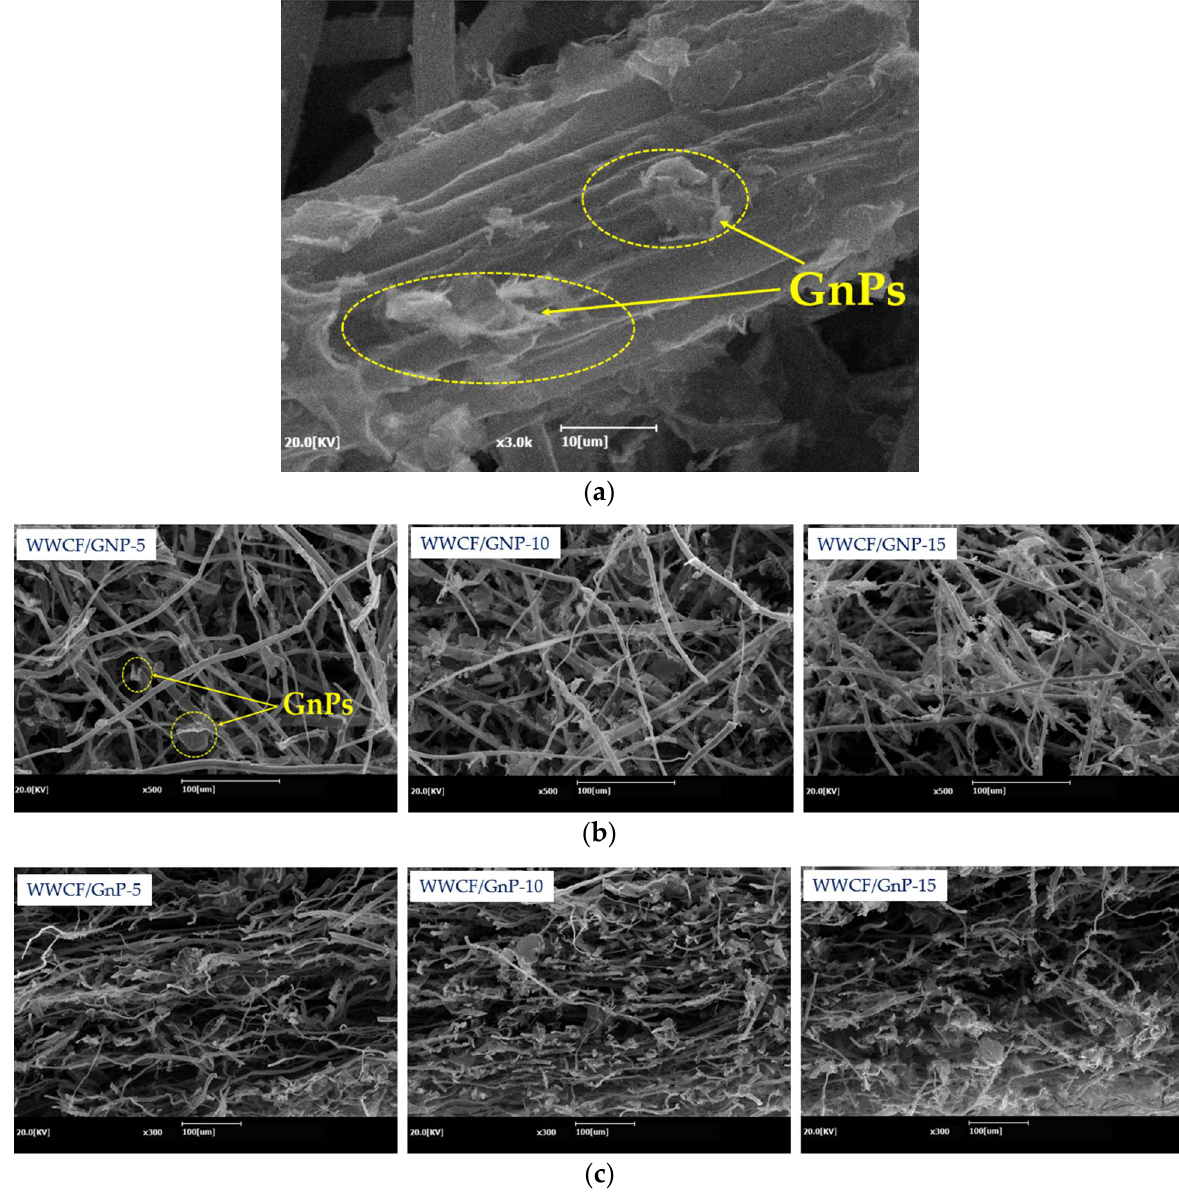
Figure 8. Scanning electron microscopy (SEM) images for ( a ) magnification: 3000×, ( b ) the surface, and ( c ) cross-section of waste wood cellulose fiber/graphene nanoplatelet (WWCF/GnP) carbon papers.